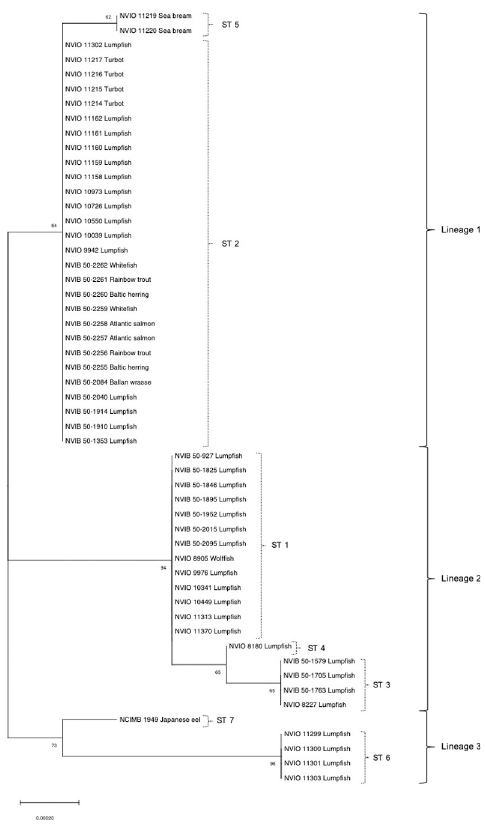
Fig 1. Phylogenetic reconstruction (MLSA) of 53 isolates of P . anguilliseptica based on the concatenated aroE , recA , rpoB , ileS , rpoD , glnS , atpD , gyrB and carA gene sequences. Bootstrap support values shown next to the branches. The length of the scale bar corresponds to 0.00020 substitutions per site. Stapled brackets refer to STs identified. Unstapled brackets refer to the major lineages formed following the phylogenetic reconstruction. Annotation: Norwegian Veterinary Institute Bergen/Oslo (NVIB/NVIO), isolate number, fish species.